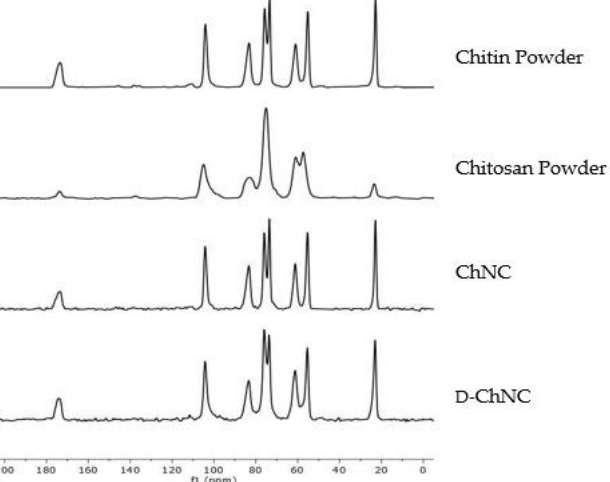
Figure A3. 13 C NMR spectra for chitin powder, chitosan powder, chitin nanocrystals (ChNC), and